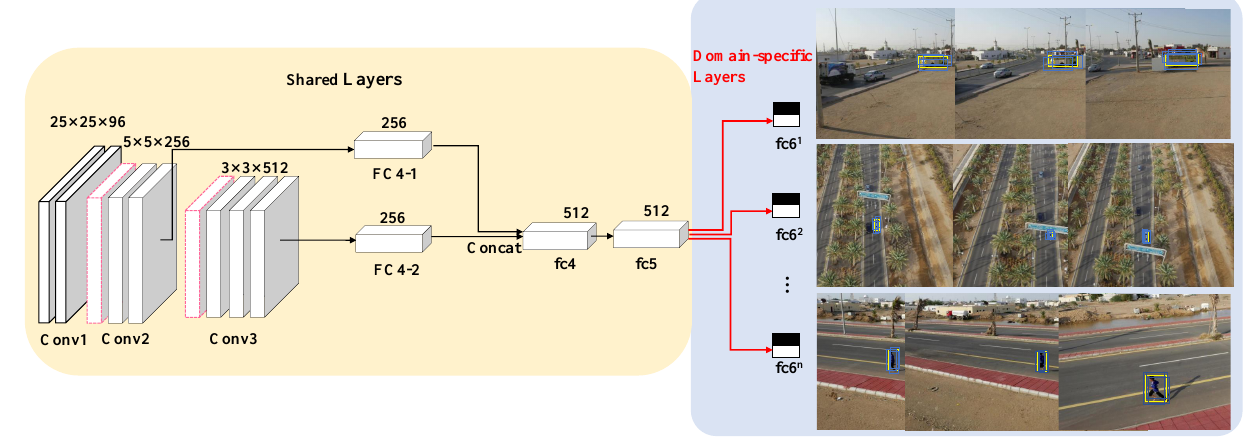
Figure 3. The architecture of base deep CNN and tracking network, consisting of shared layers and n branches of domain-specific layers.